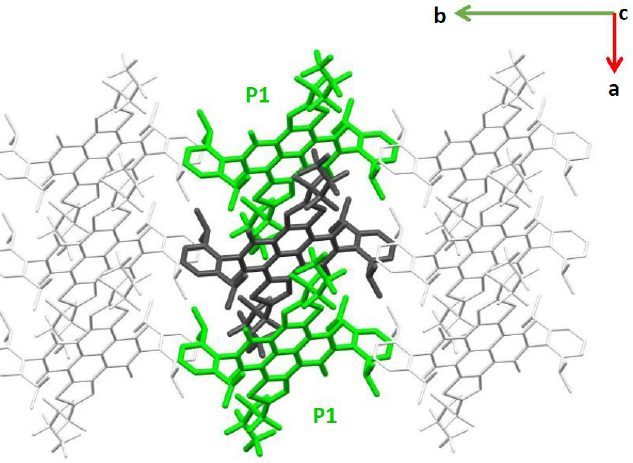
Figure 2. The most relevant charge transport path (P1, from the central dark gray to the lateral green molecules), shown within a portion of the α-NDTI crystal. The view is along the c axis.